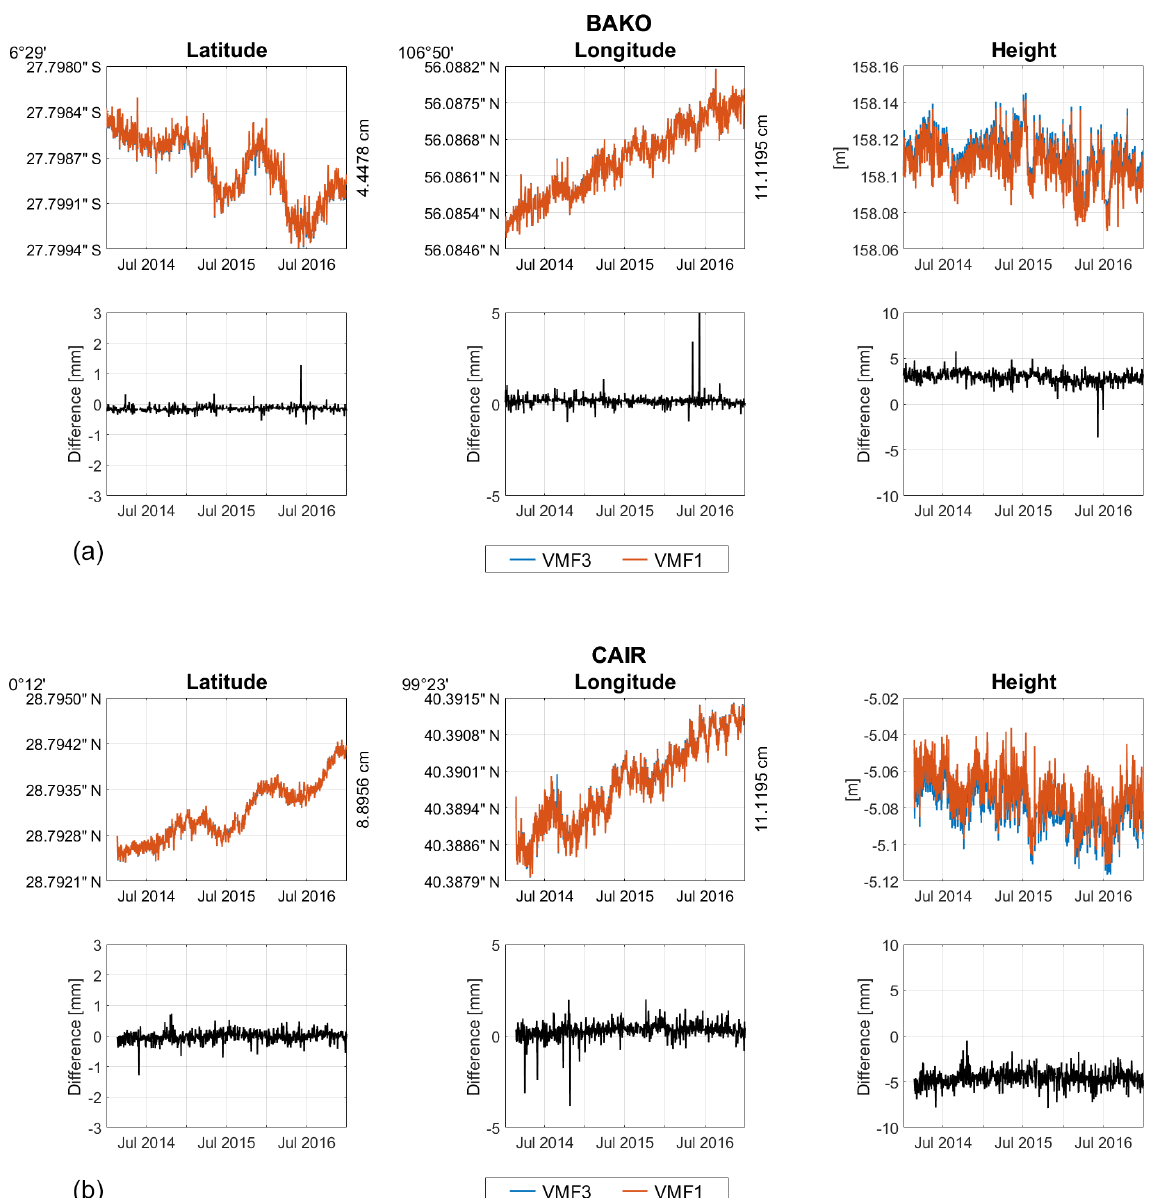
Figure 5. Estimated coordinates from VMF3 and VMF1 and their differences for station BAKO (a) and CAIR (b) . On the right side of the latitude and longitude plot, max-min value in cm is